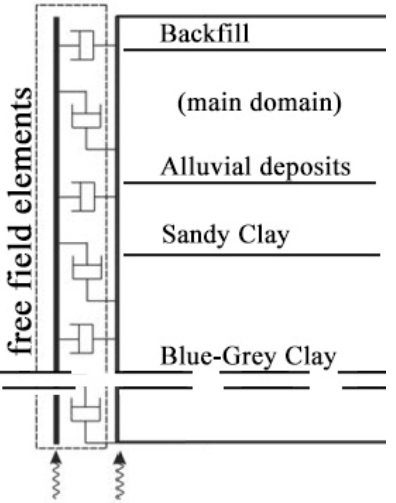
Figure 17. Free field elements (After References [38,39], modified).